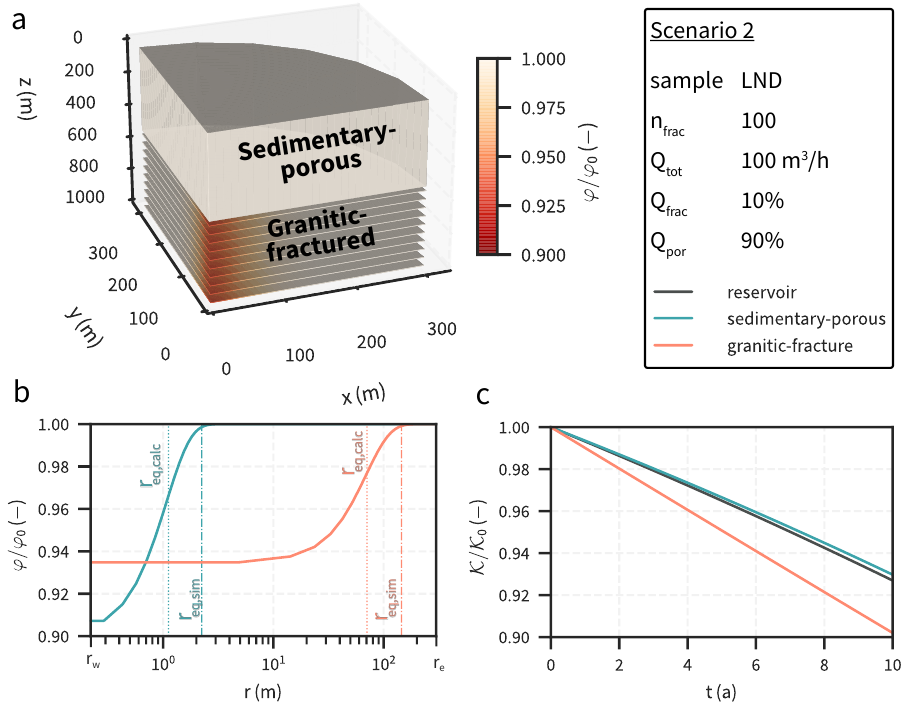
Figure 3. Reservoir simulation results of scenario 2. ( a ) Conceptual view of the reservoir model with the injection well at the origin. ( b ) Porosity change along the horizontal flow axis at the end of the simulation as well as the previously calculated and simulated equilibrium lengths. ( c ) Effective permeability change in the layers and the reservoir over the duration of the